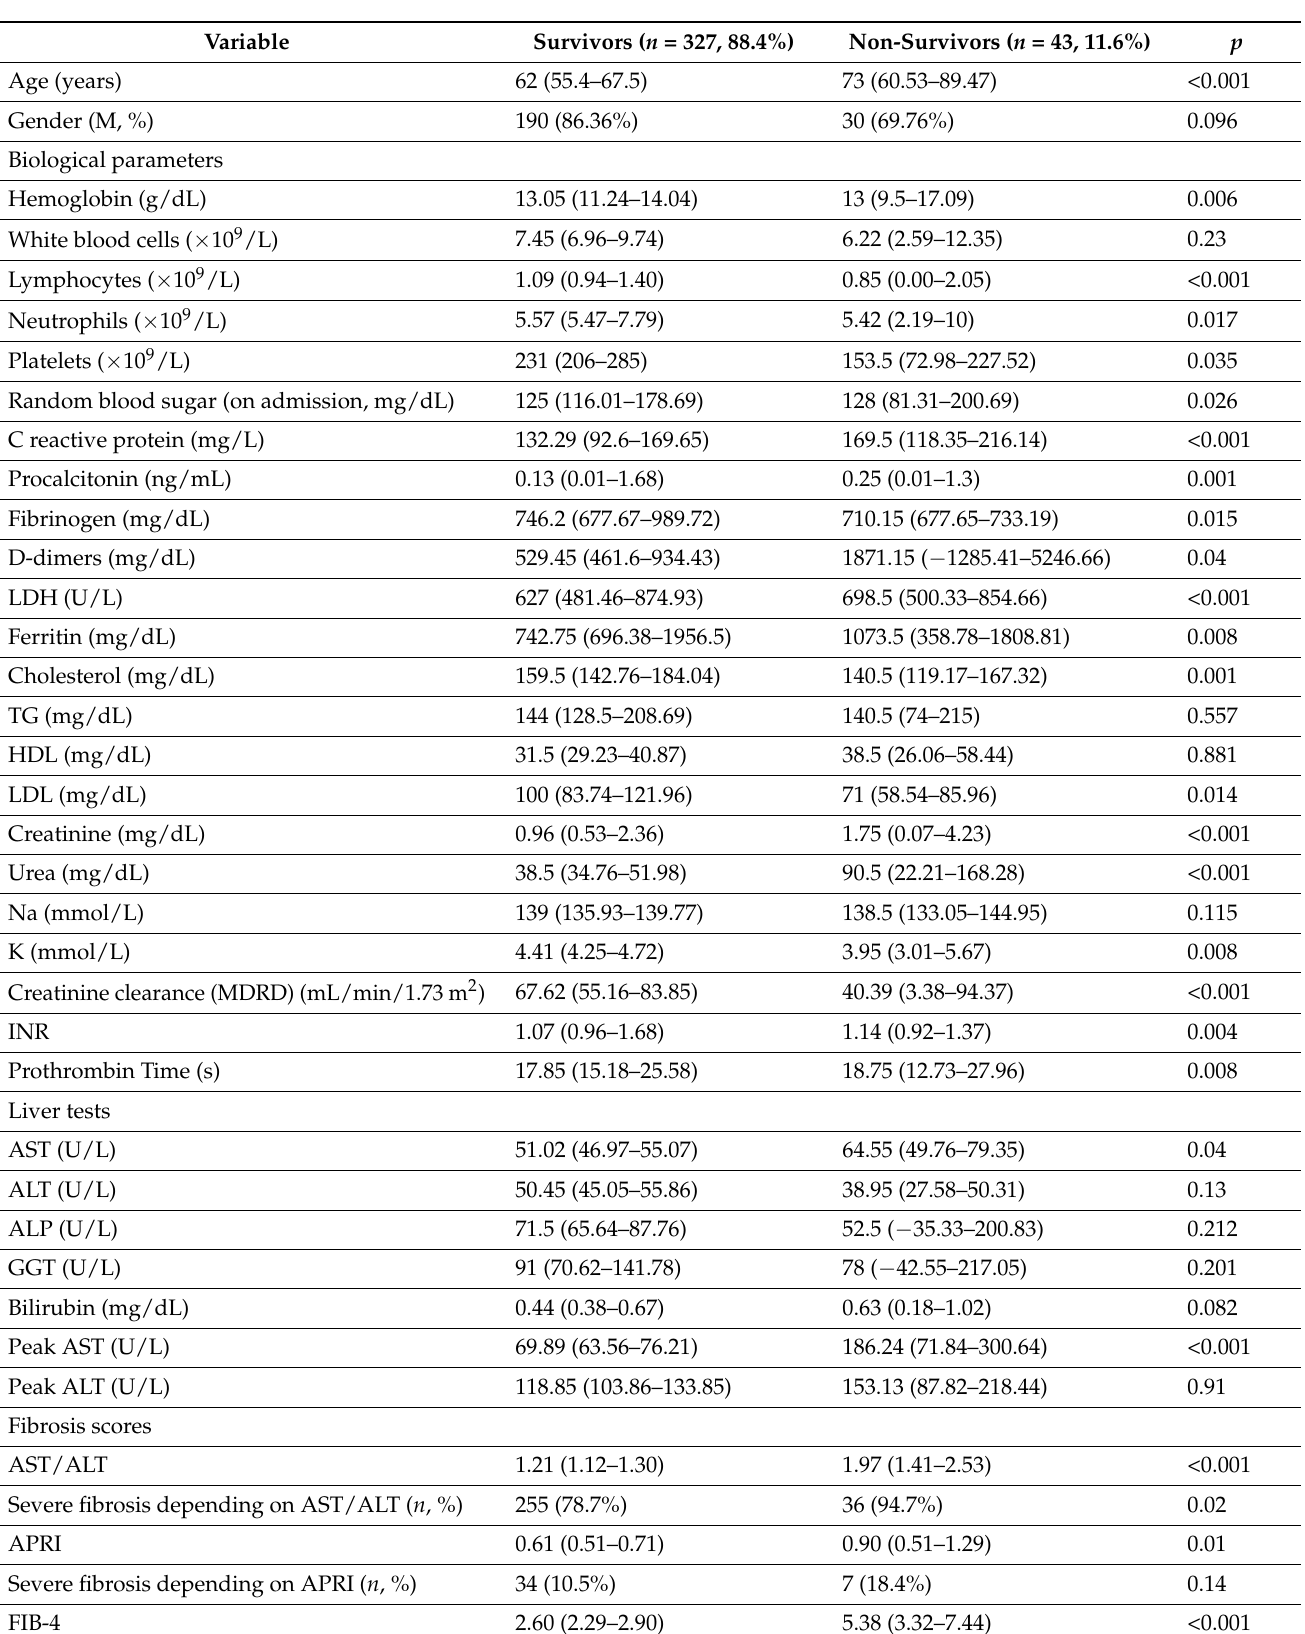
Table 3. Univariate comparison between survivors and